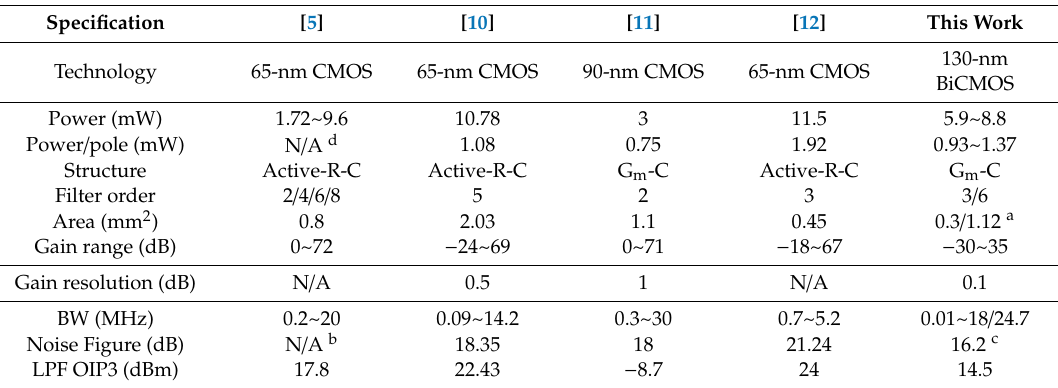
Figure 16. Measured frequency tuning response with filter order programmability (LPF order varies from third-order to sixth-order).